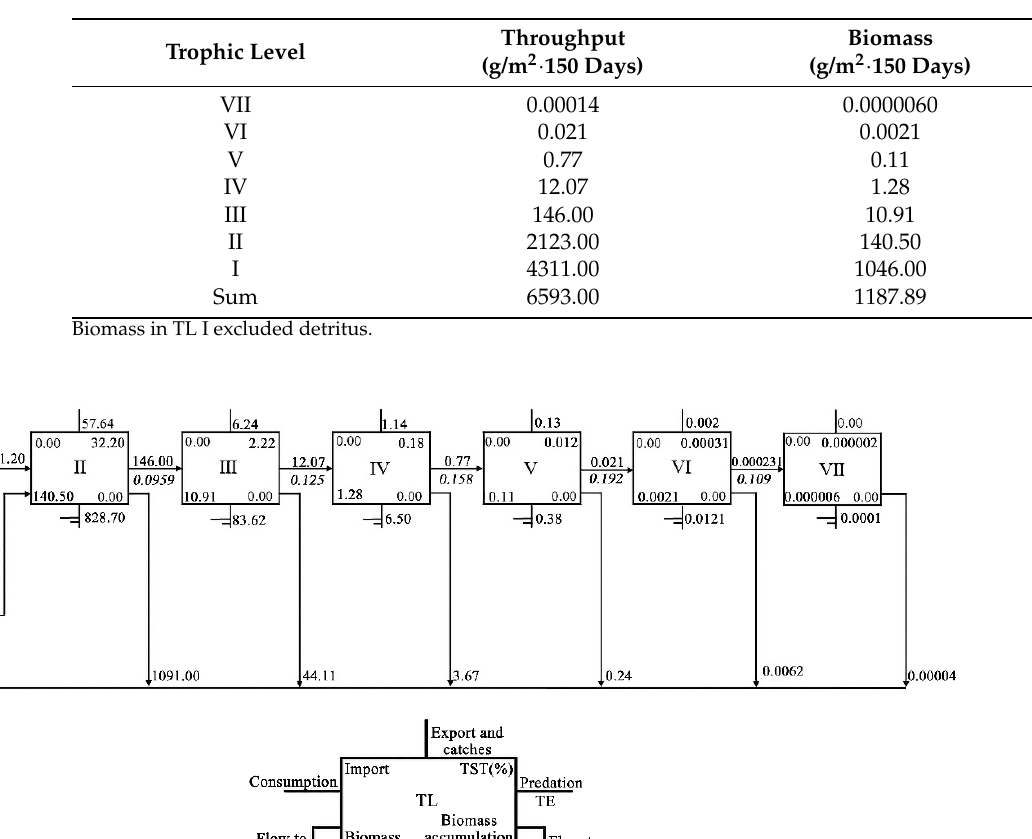
Table 4. Distribution of throughput, biomass and catch in the FMRP culture system.